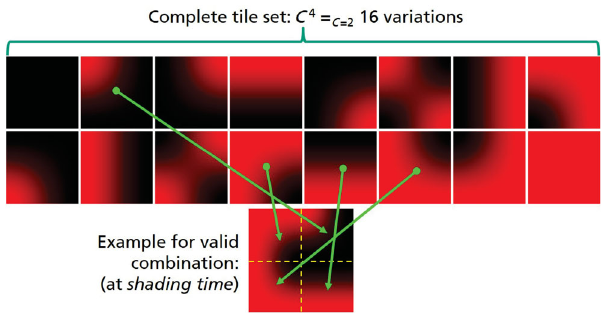
Abstract tile set of minimum size based on 2 corner types (red and black), leading to 16 variations, indicating corner compatibilities (above). Example of 2 × 2 neighborhood construction